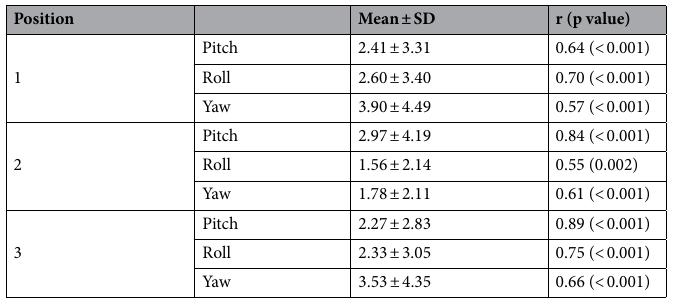
Table 3. Difference between the two sessions Differences, presented as absolute mean and standard deviation (SD), between the mean of the 1st and 2nd recording (done in the first session) and the mean of the 3rd and 4th recording (done in the second session) for each axis are shown. Pearson correlation coefficients (r) and p value are also